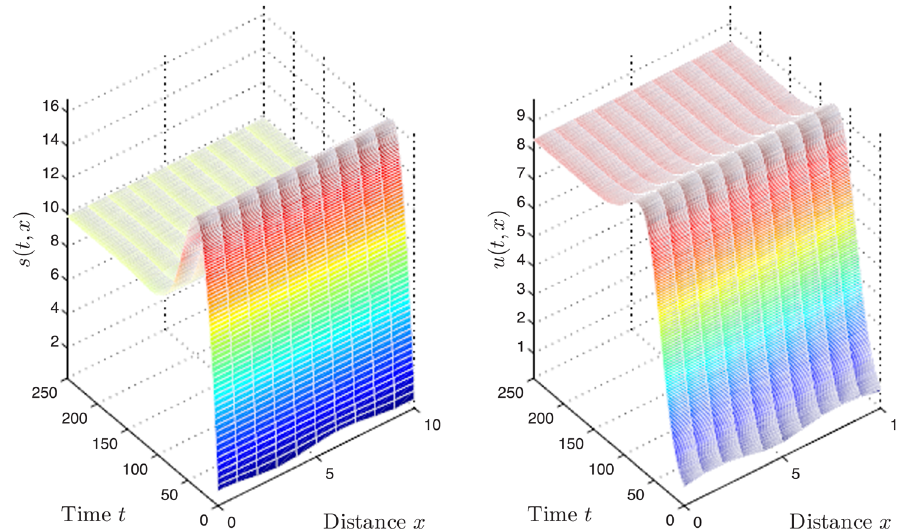
Figure 3: Numerical solutions of system ( 59 ) subject to the second set of parameters.